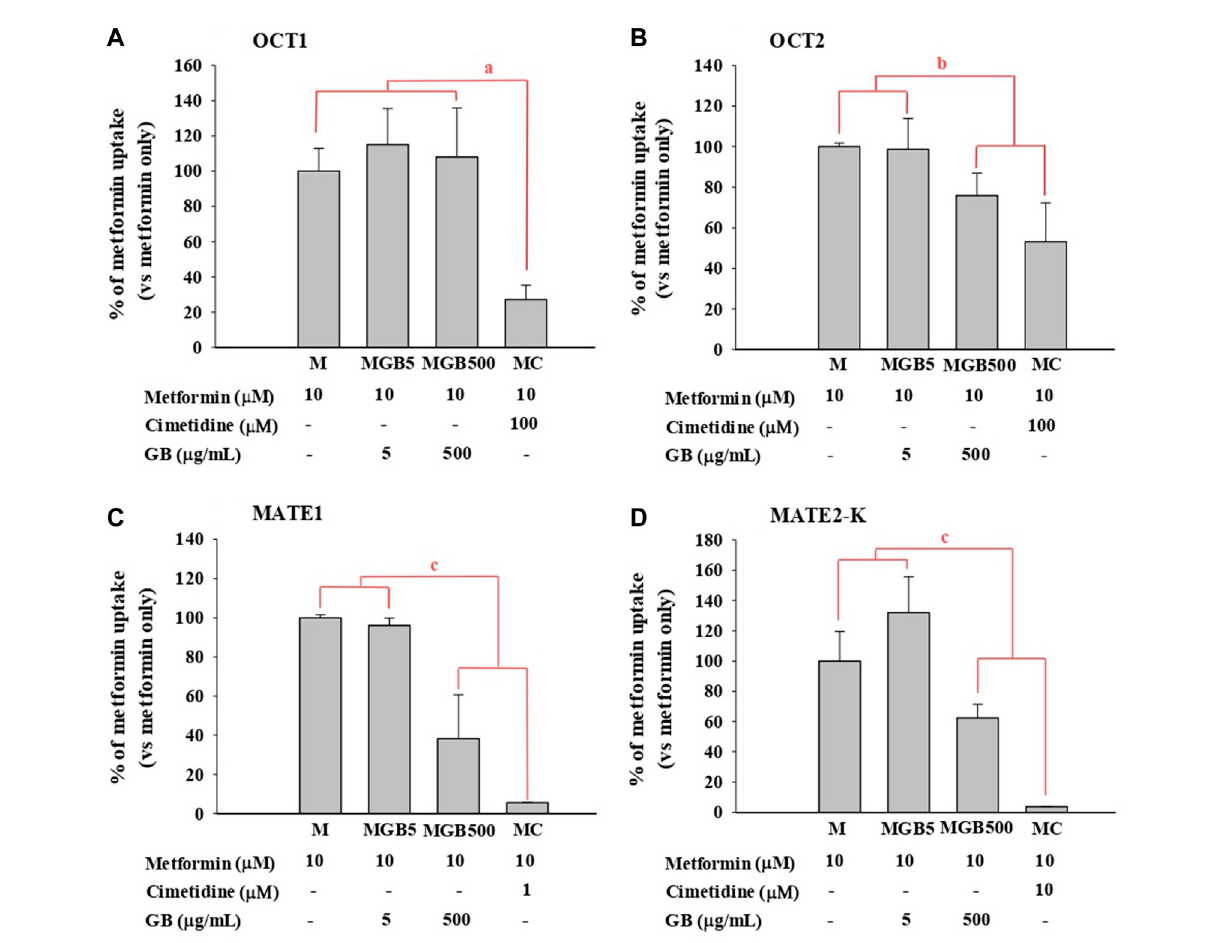
FIGURE 1 .Metformin uptake in HEK293 cells overexpressing (A) hOCT1, (B) hOCT2, (C) hMATE1, and (D) hMATE2-K. Cimetidine at 100, 100, 1 and 10 μ M was used as a well-known of OCT1, OCT2, MATE1 and MATE2-K, respectively. a MC group was signi fi cantly different ( p < 0.05) from other groups. b MGB500 andMCgroupsweresigni fi cantlydifferent( p < 0.05)fromMandMGB5groups. c MGB500 andMCgroupsweresigni fi cantly different( p < 0.05) from M and MGB5 groups, and also there was a signi fi cant difference ( p < 0.05) between MC and MGB500